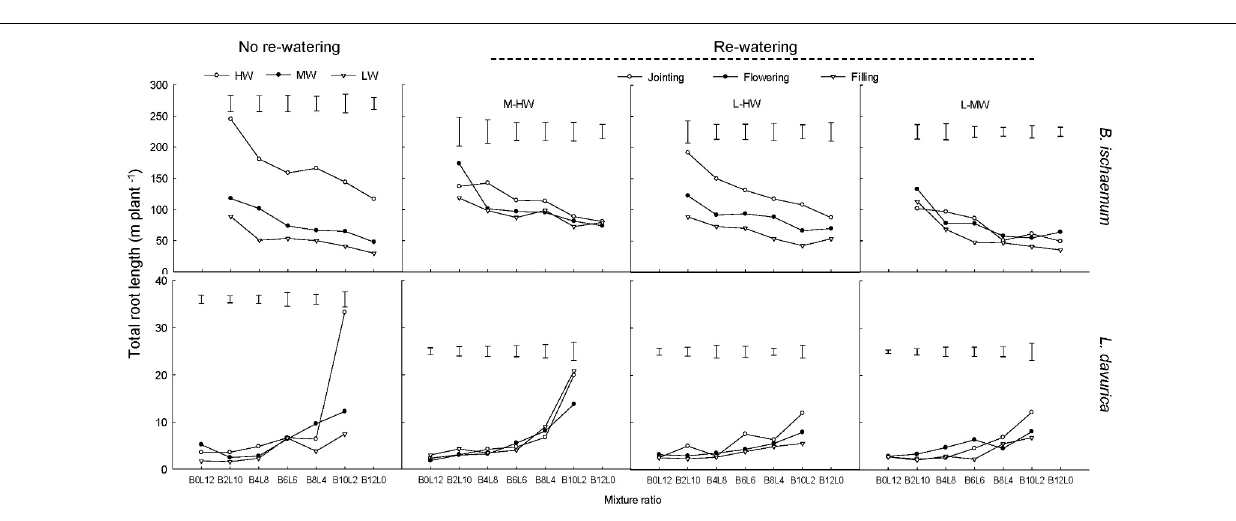
FIGURE 3 | Total root length (TRL) per plant of B. ischaemum (B) and L. davurica (L) at various mixture ratios under each water treatment. HW: 80 ± 5% FC; MW: 60 ± 5% FC; LW: 40 ± 5% FC; M-HW: soil water content increased from MW to HW; L-MW: soil water content increased from LW to MW; L-HW: soil water content increased from LW to HW. The vertical bars indicate the LSD values ( P ≤ 0.05) for the TRL difference of each species among water treatments at each mixture